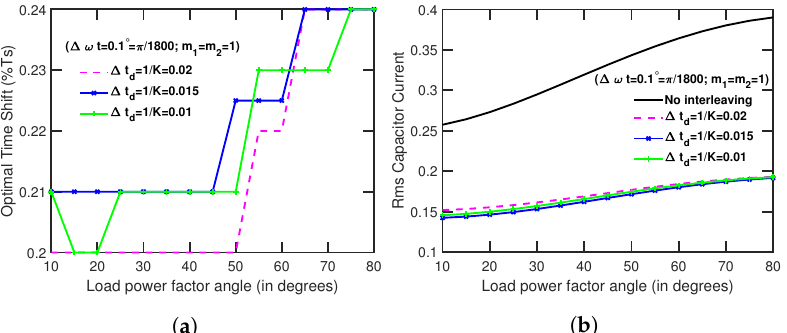
Figure 7. ( a ) Impact of changing the time shift increment in accuracy of the result in Algorithm 1, ( b ) corresponding to i c , rms .